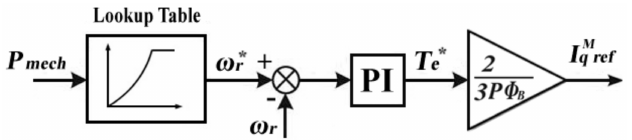
Figure 4. Block diagram of obtaining the maximum Iq in the machine-side converter